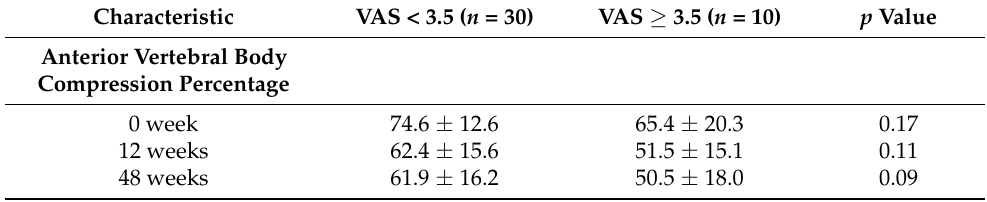
Table 3. Radiographic